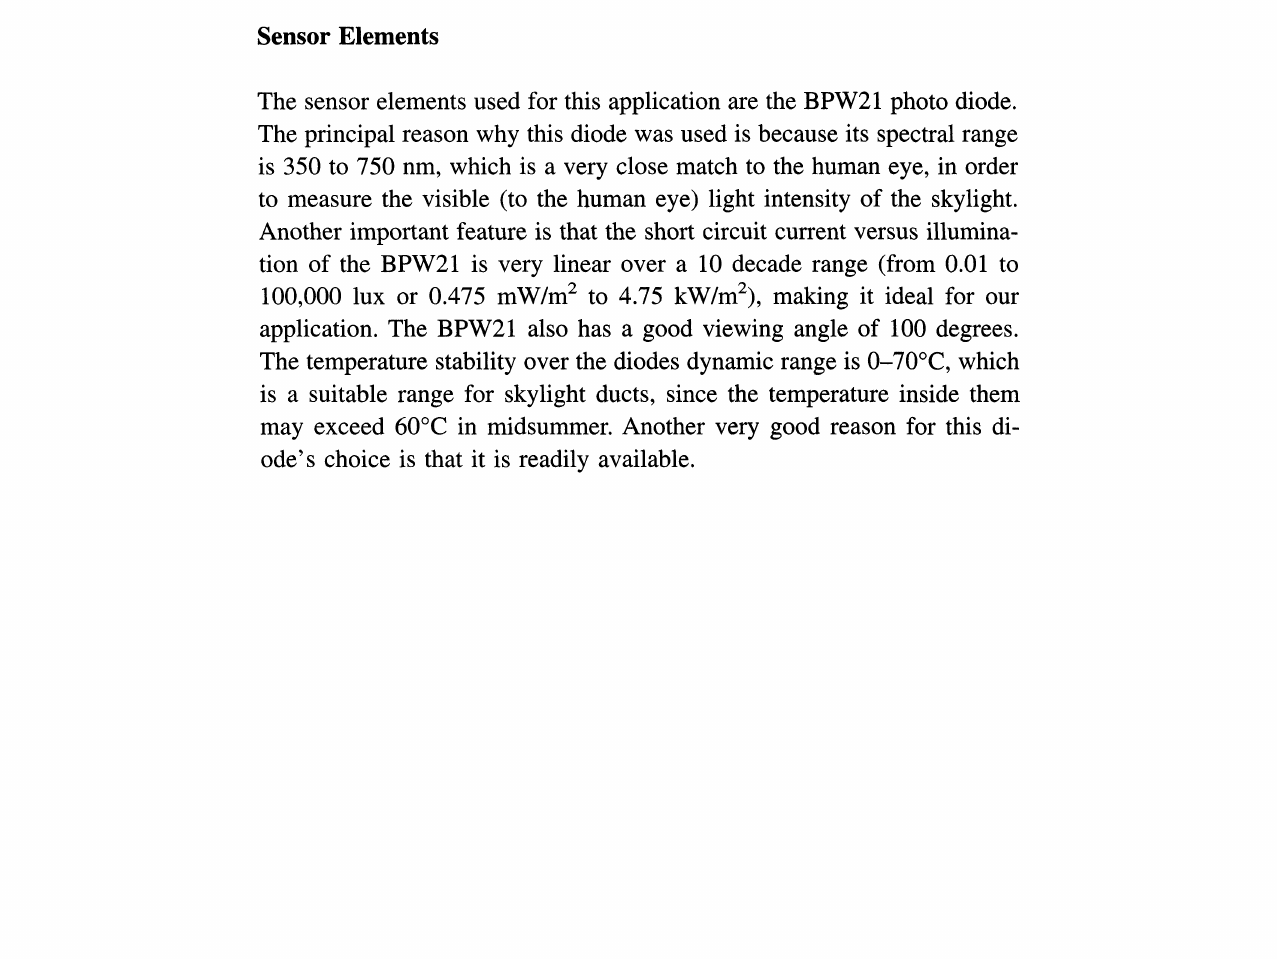
FIGURE Block Diagram of Sensor Circuit.